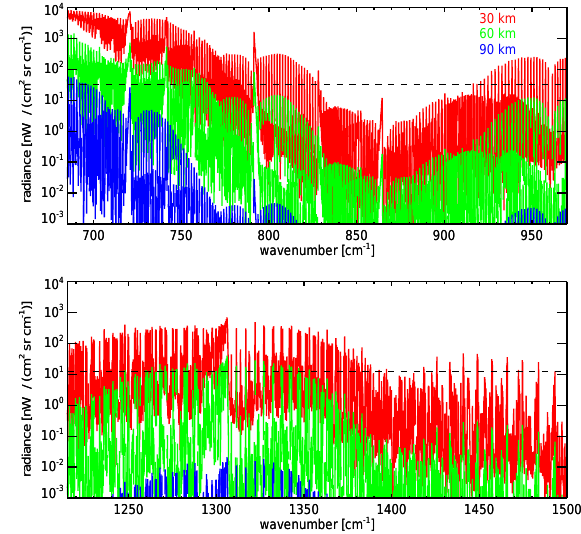
Fig. 1. (top) CO 2 spectra for midlatitude conditions. (bottom) CH 4 spectra for midlatitude conditions. The dashed black line shows the typical MIPAS noise equivalent spectral radiance (NESR) value.